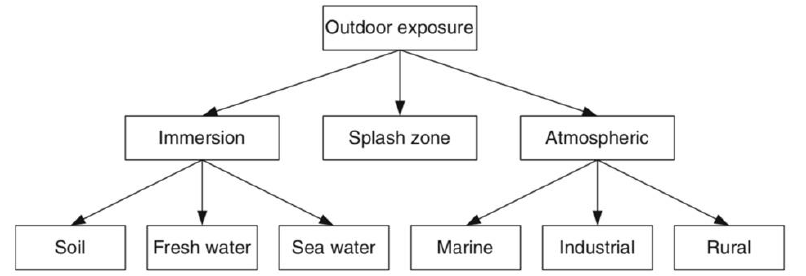
Figure 1. The types of environments that are encountered by anticorrosion coatings [50].